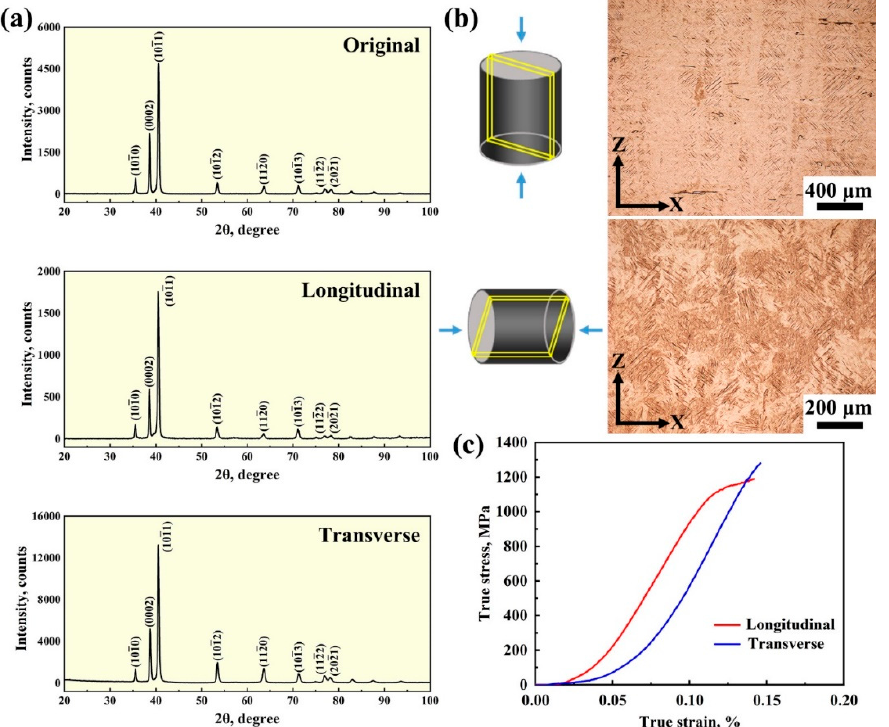
Figure 2. ( a ) XRD patterns of α / α′ phase of the original and compressed samples; ( b ) cross-sectional microstructures of compressed samples; ( c ) compressive true-stress–true-strain curves of transverse and longitudinal samples. Table 1. Typical slip modes and the corresponding Taylor axes in α -Ti